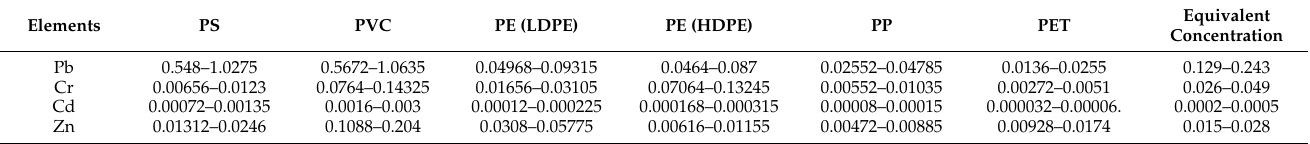
Table 13. Heavy metals concentrations in ( µ g m − 3 ) for six types of plastic and relative TEF for particulate soot emissions in the range of 8–15 (mg m − 3 ) daily